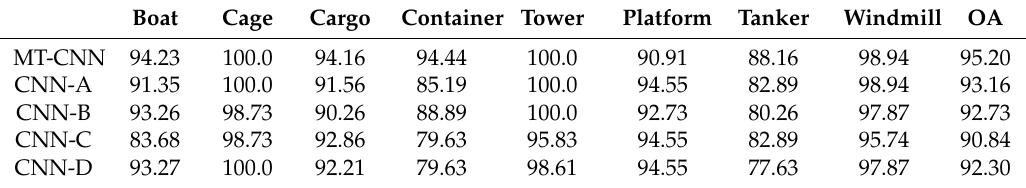
Table 11. Classification accuracies (%) of different CNN models.